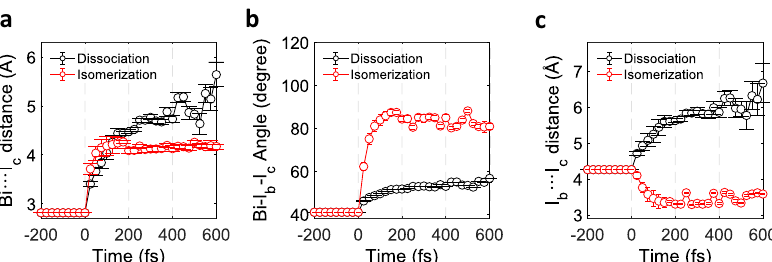
Fig. 6 Comparison of the structural motions for the dissociation and roaming-mediated isomerization channels. a Bi···I c distance, b Bi-I b -I c angle, and c I b ···I c distance for the BiI 3 in the dissociation pathway (black) and the roaming-mediated isomerization pathway (red) are shown. The structural motions are obtained in the structural fi t on Δ S iso ( q , t ). The error bars represent the one-standard-deviation error values estimated from the relevant error values obtained from the covariance matrix of the coef fi cients of quartic polynomials for the time delays earlier than 175 fs and the averaged one-standard- deviation error values obtained from the fi ts starting from ~5000 random structures for the time delays later than